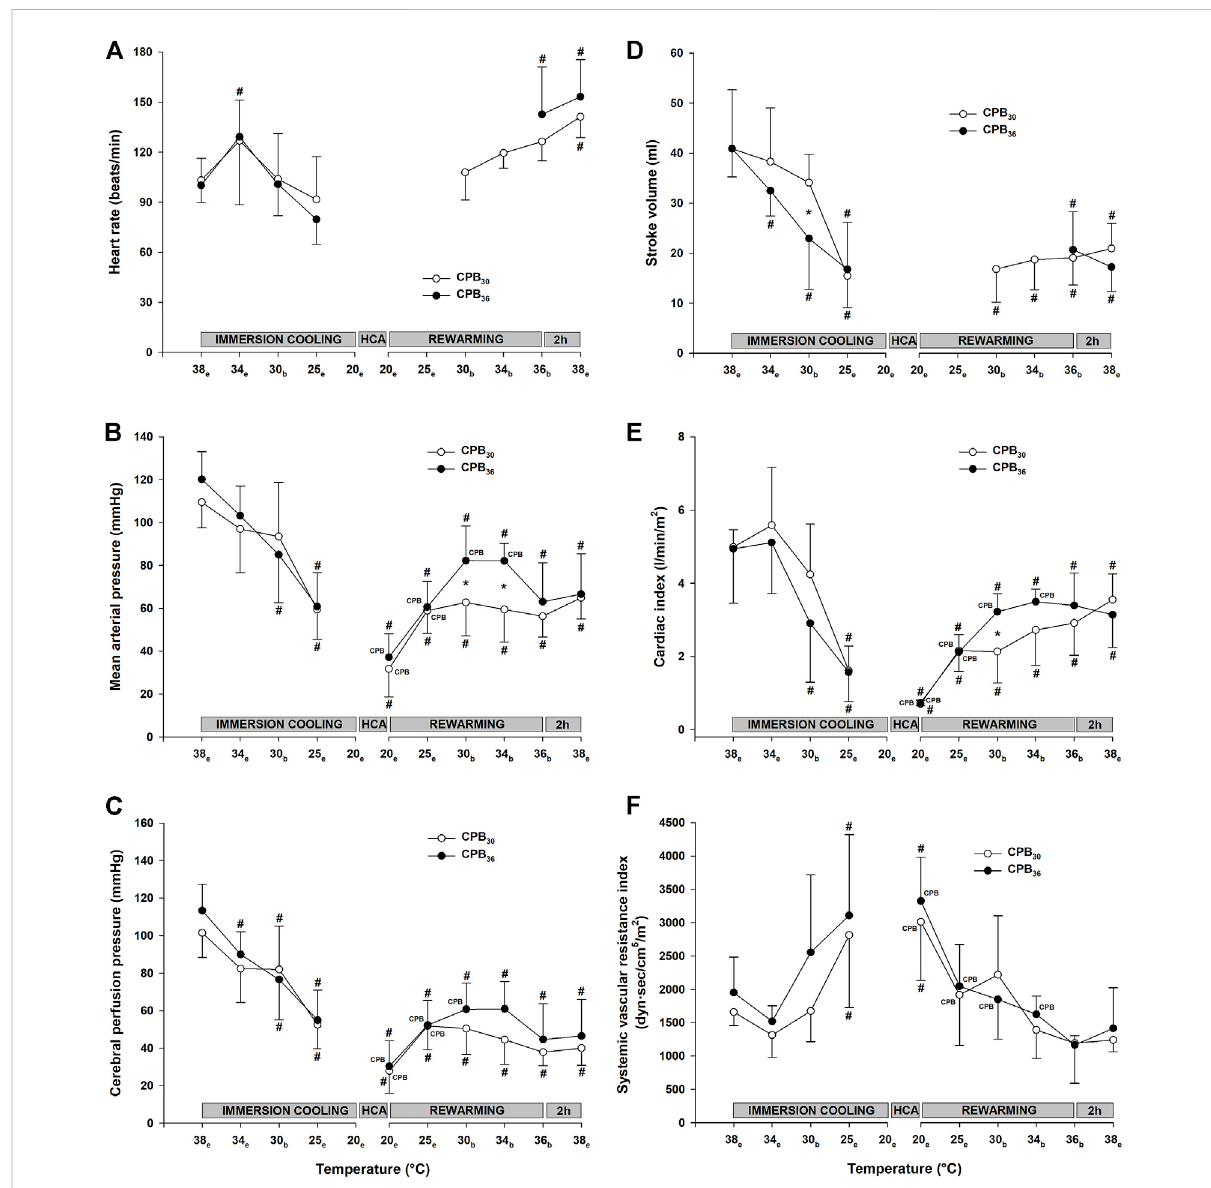
FIGURE 3 Hemodynamic variables. (A) : heart rate, (B) : mean arterial pressure, (C) : cerebral perfusion pressure, (D) : stroke volume, (E) : cardiac index, (F) : systemic vascular resistance. Temperature measured in: e – esophagus; b – bladder. Data presented as mean and SD. # p < 0.05 vs. intragroup baseline; * p < 0.05 vs. corresponding value in another group; CPB – variables measured during ongoing